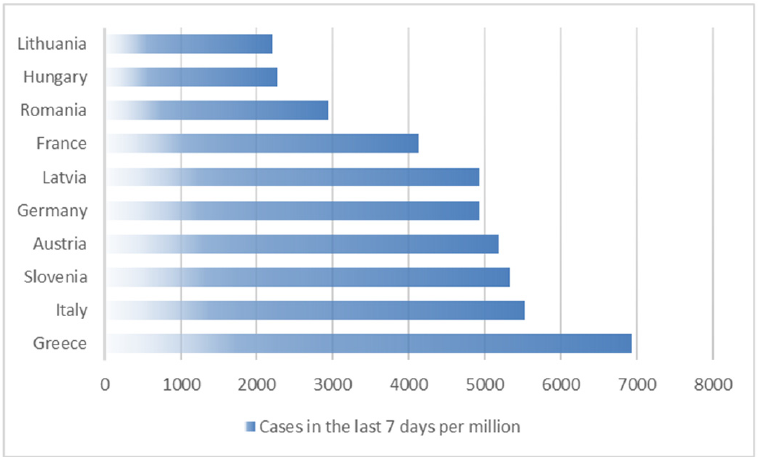
Figure 1. Top 10 countries in the European Union with the highest number of COVID-19 cases in the last 7 days per million as of 4 August 2022.